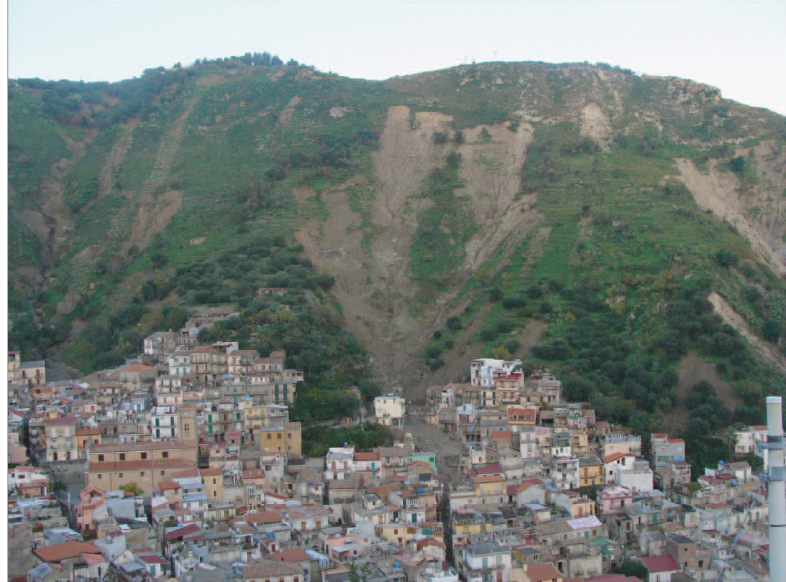
Fig. 3. Post-event panoramic view of